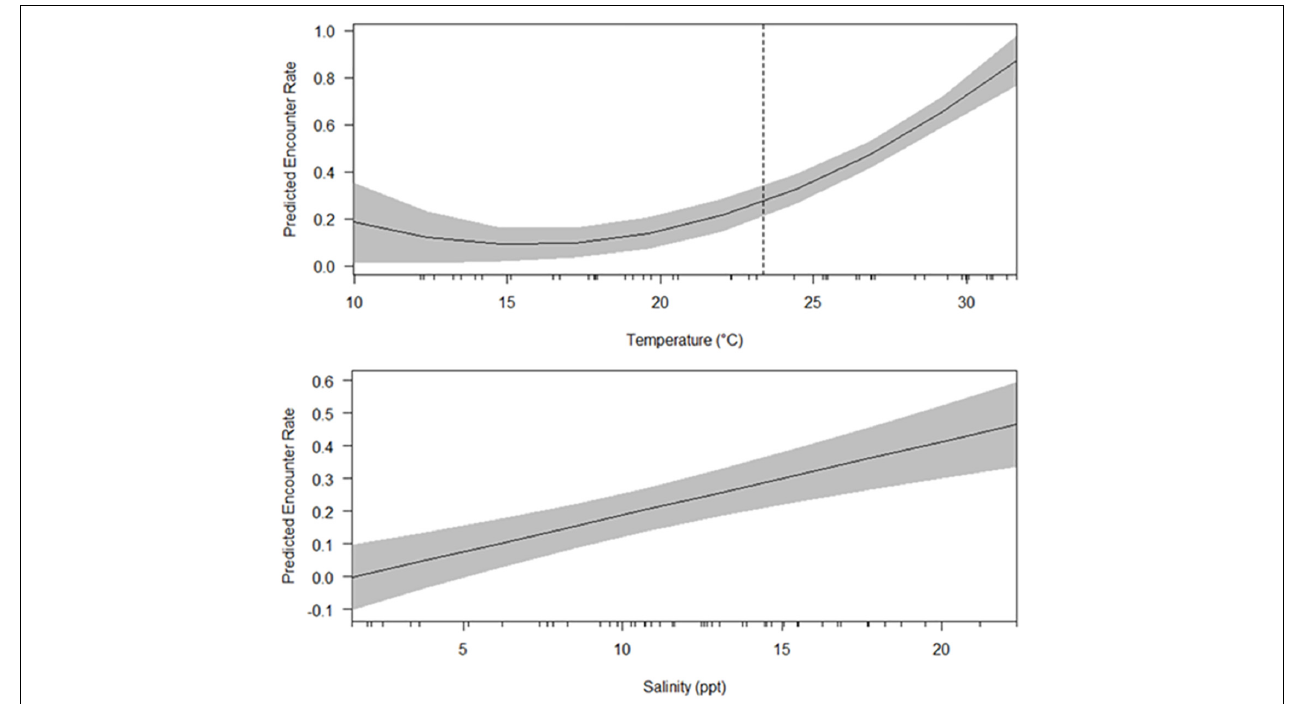
FIGURE 3 | Predicted encounter rates (dolphins/km) of bottlenose dolphins ( Tursiops truncatus ) in upper Galveston Bay, Texas resulting from a multiple regression model with water temperature ( ◦ C) and salinity (ppt) as predictor variables. Tick marks on x -axis represent observed values. A breaking point of 23.37 ◦ C (dashed line) identified by segmented linear regression is